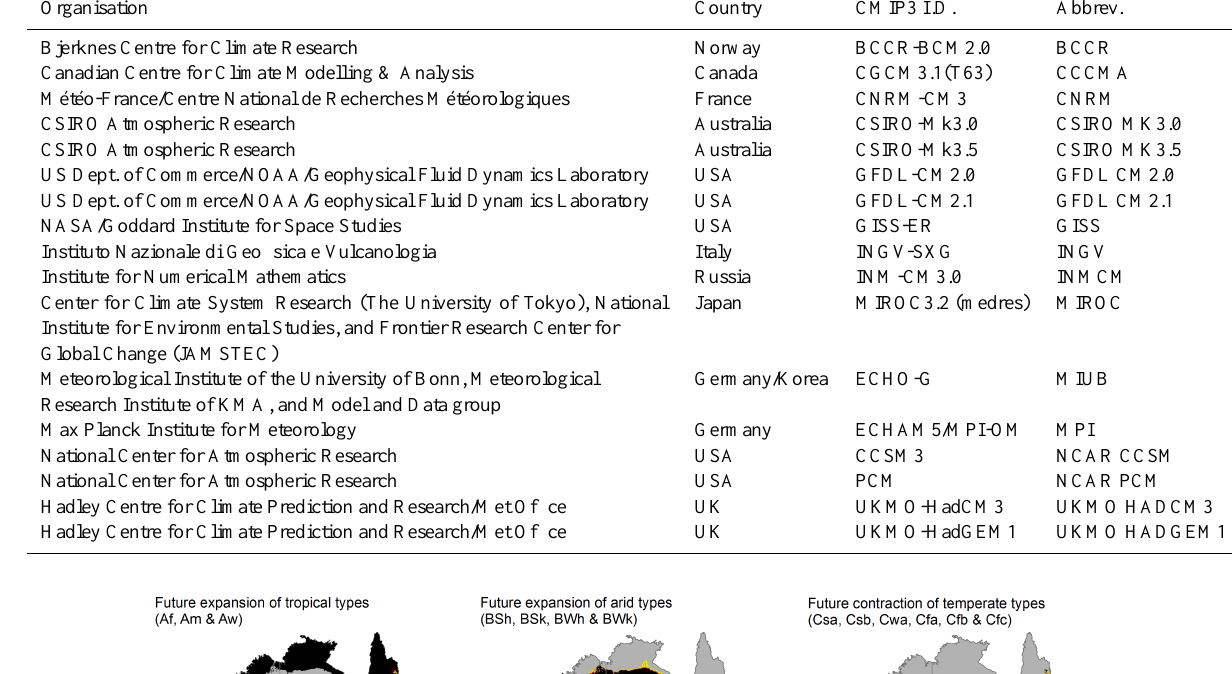
Table 2. List of GCMs used in this study also showing the abbreviations used in Fig. 2. Organisation